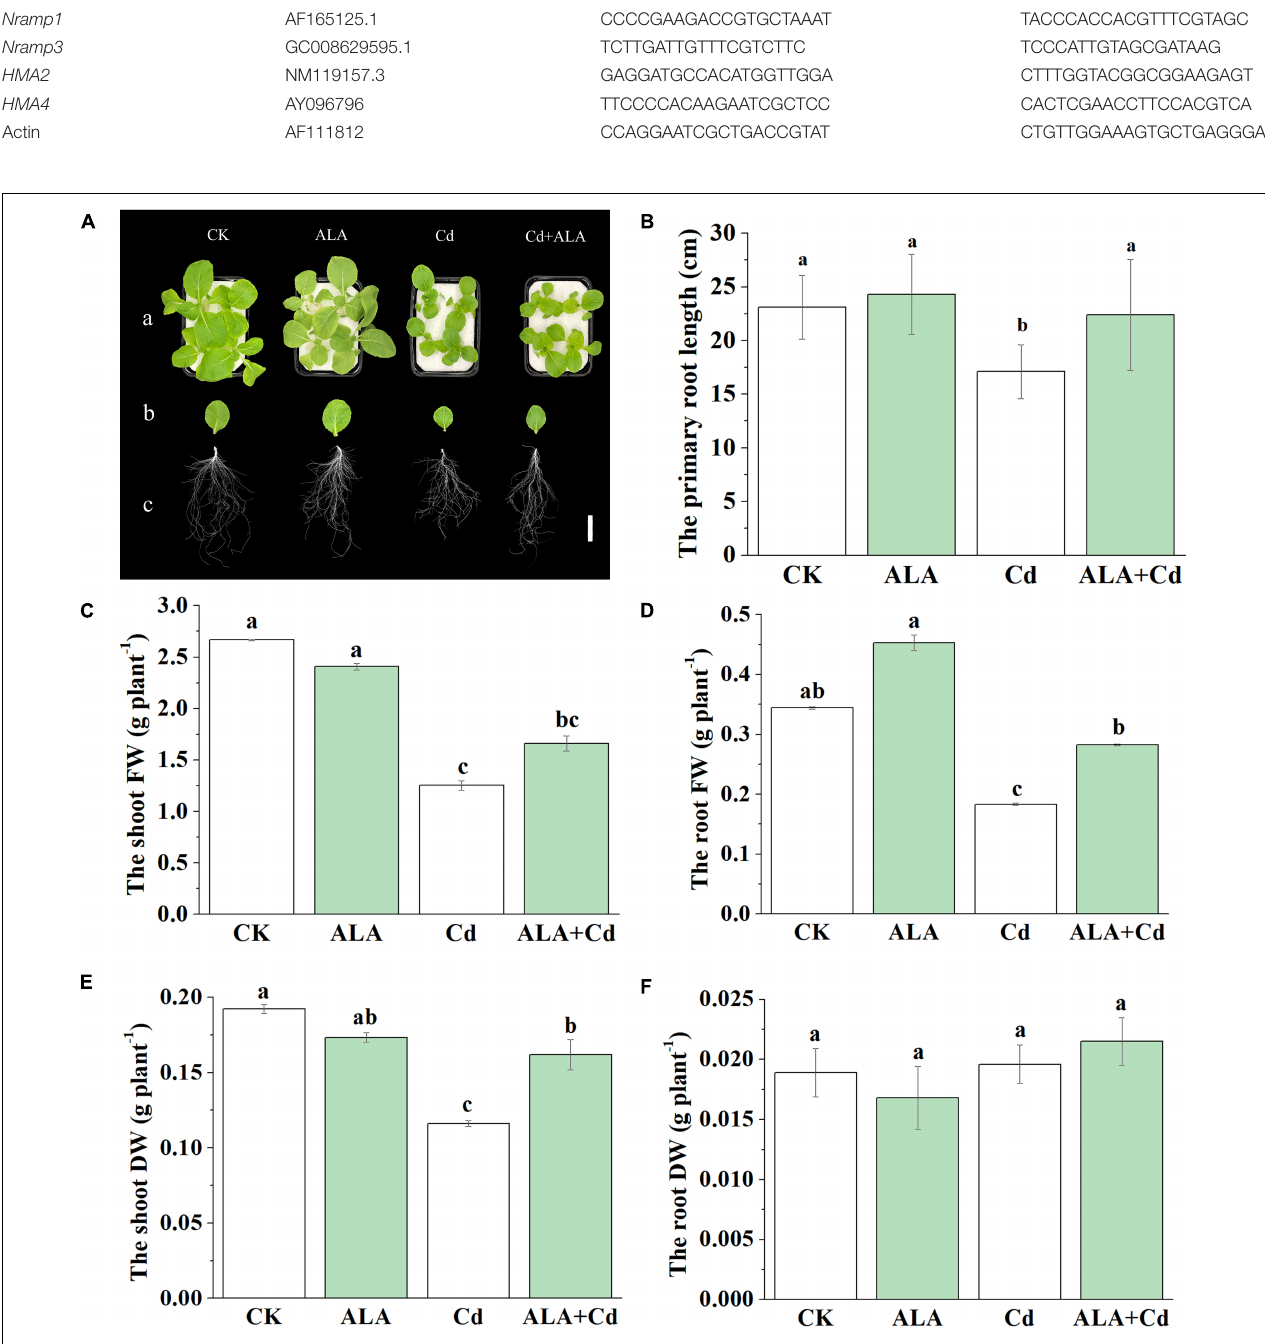
FIGURE 1 | Exogenous ALA alleviated Cd stress-induced growth inhibition in Chinese cabbage. (A) Phenotypes of individual. Bar = 5 cm. (B) Changes in primary root length. Fresh weight (FW) of shoots (C) and roots (D) . Dry weight (DW) of shoots (E) and roots (F) The 14-day-old cabbage seedlings were transferred to 1/2 Hoagland medium containing 50 µ M Cd for 7 days. About 25 mg/L 5-aminolevulinic acid (ALA) was sprayed onto the leaves, and it was applied every 3 days under ALA+Cd as well as ALA treatments. The mean ± SE are shown ( n ≥ 3). Different letters indicate significant difference among the treatments ( P < 0.05).